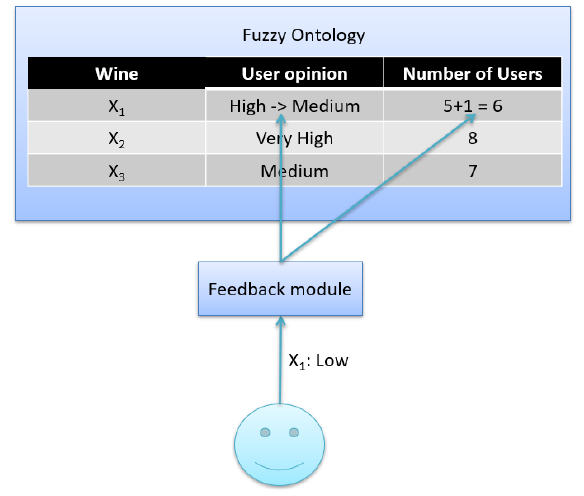
Figure 6. Feedback process